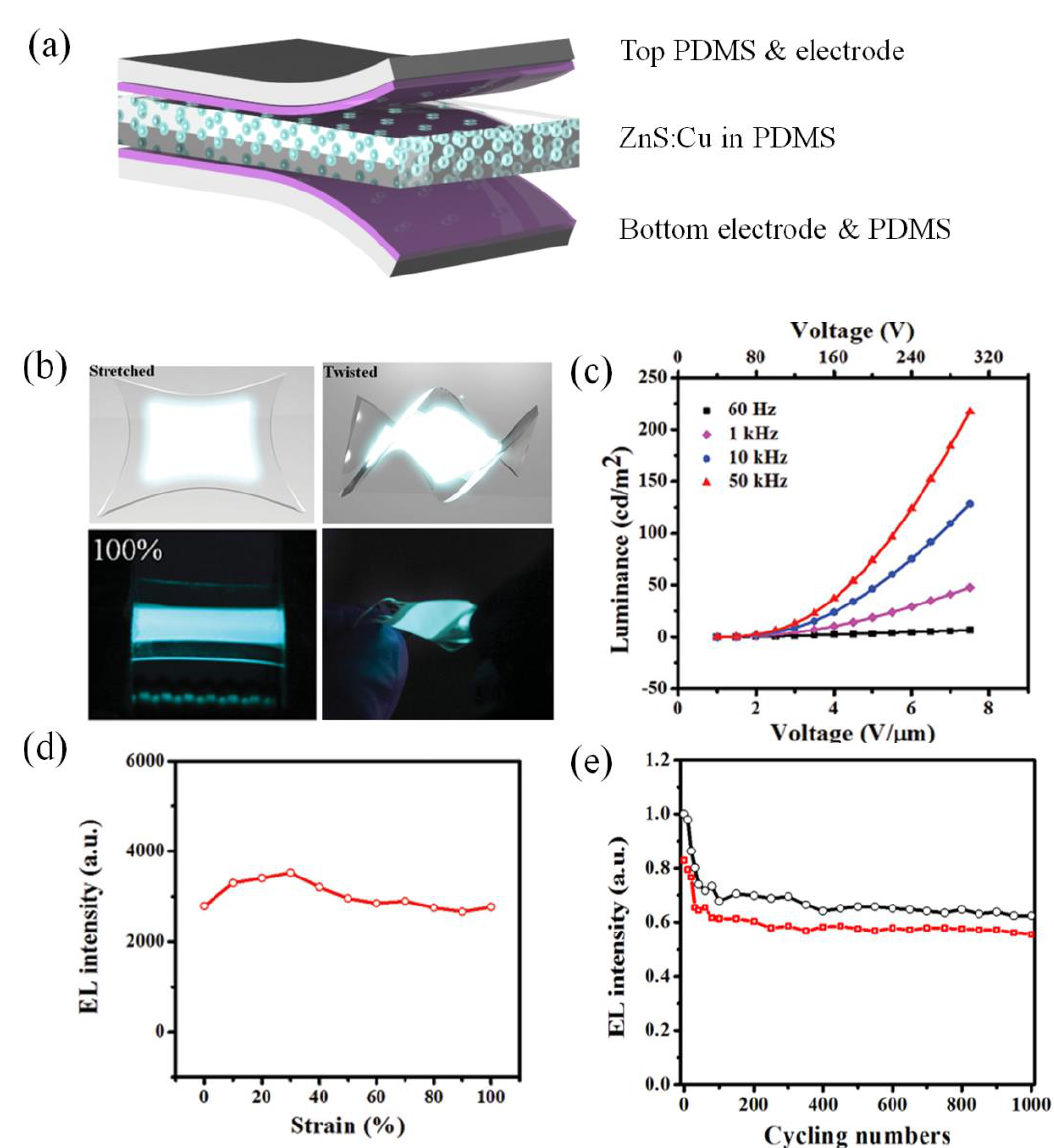
Figure 7: (a) A schematic illustration of the stretchable ACEL device architecture, which included the ZnS:Cu powders mixed in PMDS as the emissive layer and AgNW networks embedded in PDMS as the top and bottom electrodes. (b) Schematic images and photographs of the stretchable ACEL device under stretching and twisting. (c) Luminance characteristic against the applied voltages. (d) Stretching stability test of the ACEL device with the maximum strain of 100%. (e) Mechanical cycling test of the ACEL device at the stretching strain of 80%. Reproduced with permission from